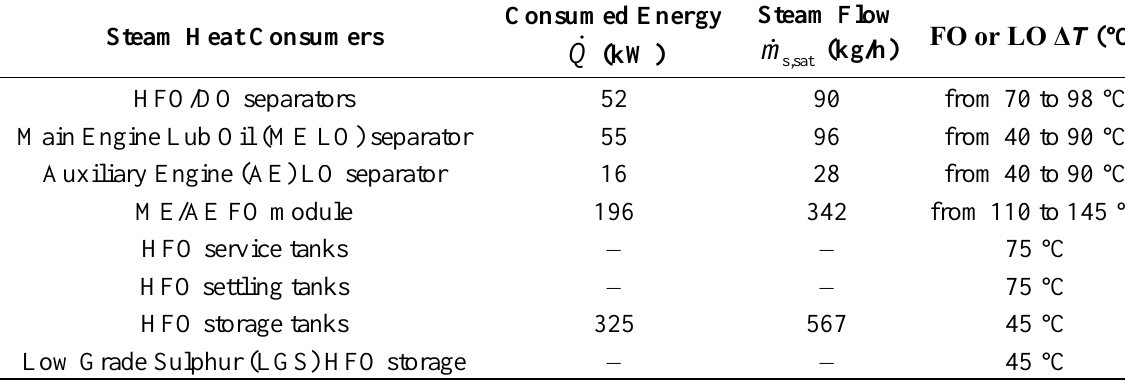
Table 1. Shipwide heat consumption during navigation for fuel and lube oil heating